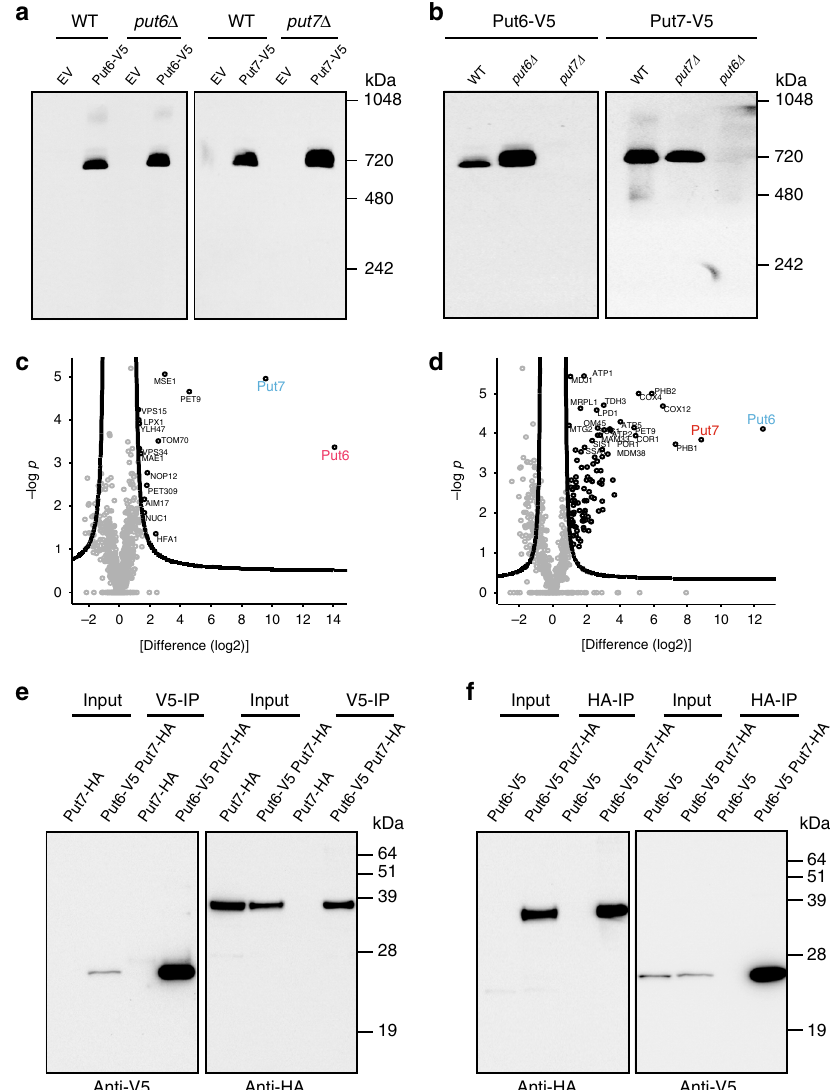
Fig. 2 Put6 and Put7 form a large hetero-oligomeric complex. a Put6 and Put7 are part of a large protein complex. Digitonin-solubilized mitochondria from BY4741 WT, put6 Δ , or put7 Δ yeast cells transformed with empty vector, Put6-V5 or Put7-V5, respectively, were resolved by Blue-native (BN) PAGE and analyzed by immunoblotting using anti-V5 antibody. Data are representative of three independent experiments. b Put6 and Put7 complex formation is dependent on each other. Mitochondria from the indicated yeast strains expressing either Put6-V5 or Put7-V5 were solubilized in a digitonin-containing buffer and analyzed by BN-PAGE/immunoblotting. Data are representative of three independent experiments. c , d Volcano plot showing the enrichment of Put6 and Put7 interacting proteins. Immunoprecipitates of digitonin-solubilized mitochondria expressing either Put6-V5 ( c ), or Put7-V5 ( d ) were analyzed by mass spectrometry. The abundance of Put6-V5 and Put7-V5 interacting proteins were normalized using immunoprecipitate obtained from cells transformed with empty vector. e , f Put6 and Put7 physically interact with each other. Mitochondria expressing the indicated proteins were solubilized in 1% digitonin-containing buffer and incubated with either anti-V5 ( e ) or anti-HA ( f ) antibodies. Input lysate (1% of mitochondrial extract) and